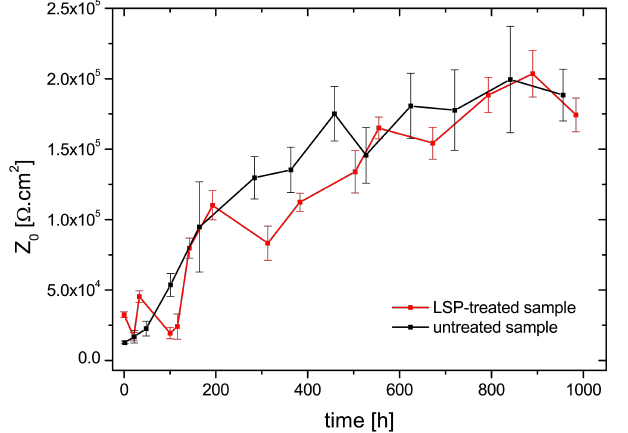
Figure 11. Time evolution of the diffusion resistance Z 0 for LSP-treated and untreated AISI